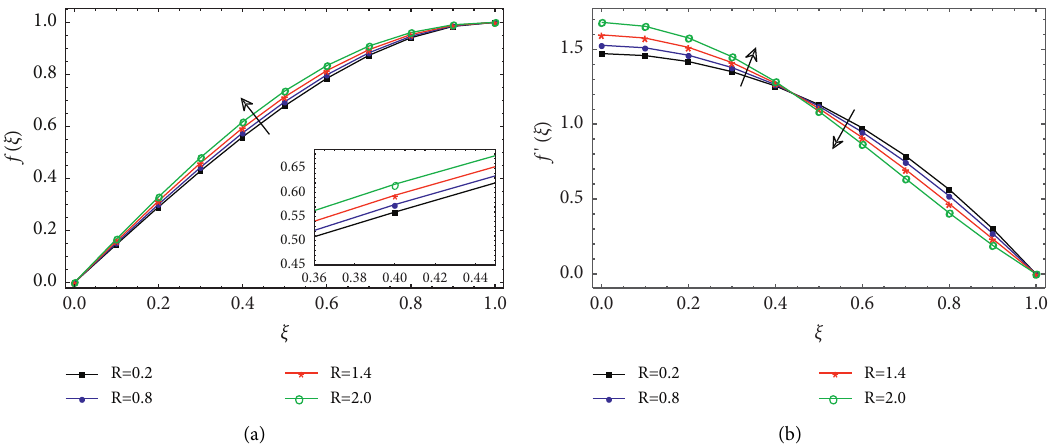
Figure 5: Effect of R on the velocity profile keeping M component of velocity.